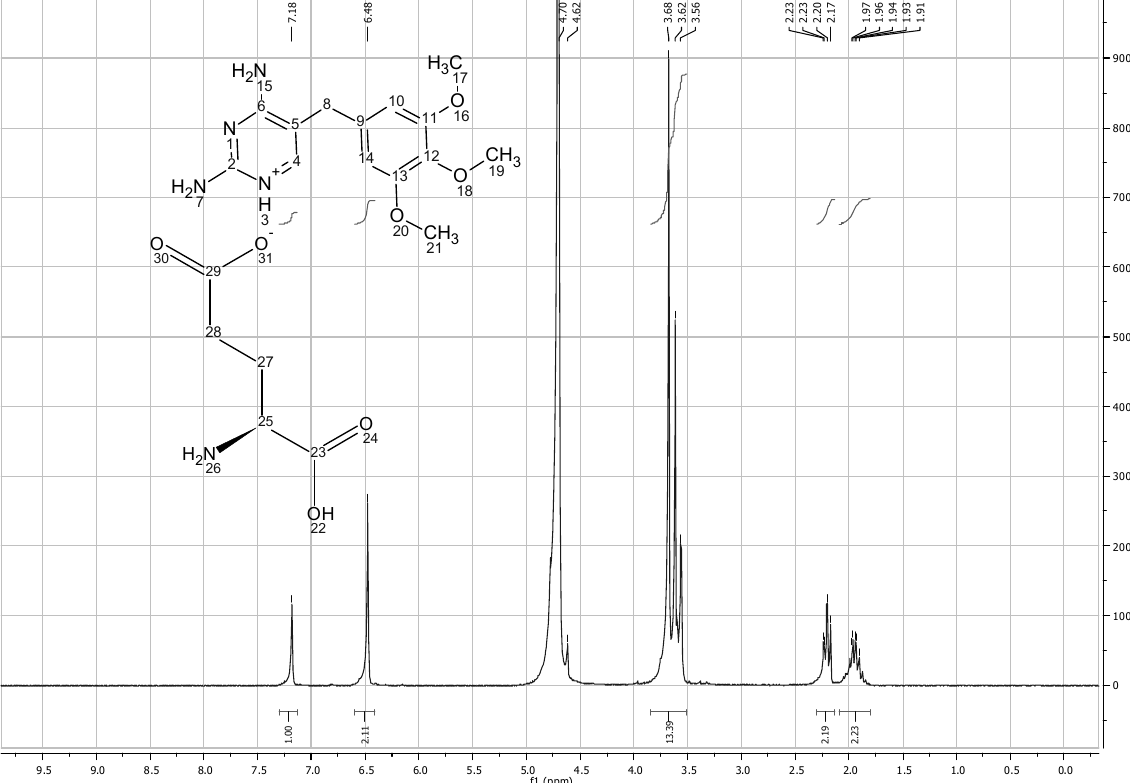
Figure 10. 1 HNMR spectra of trimethoprim L -glutamate solubilized in D